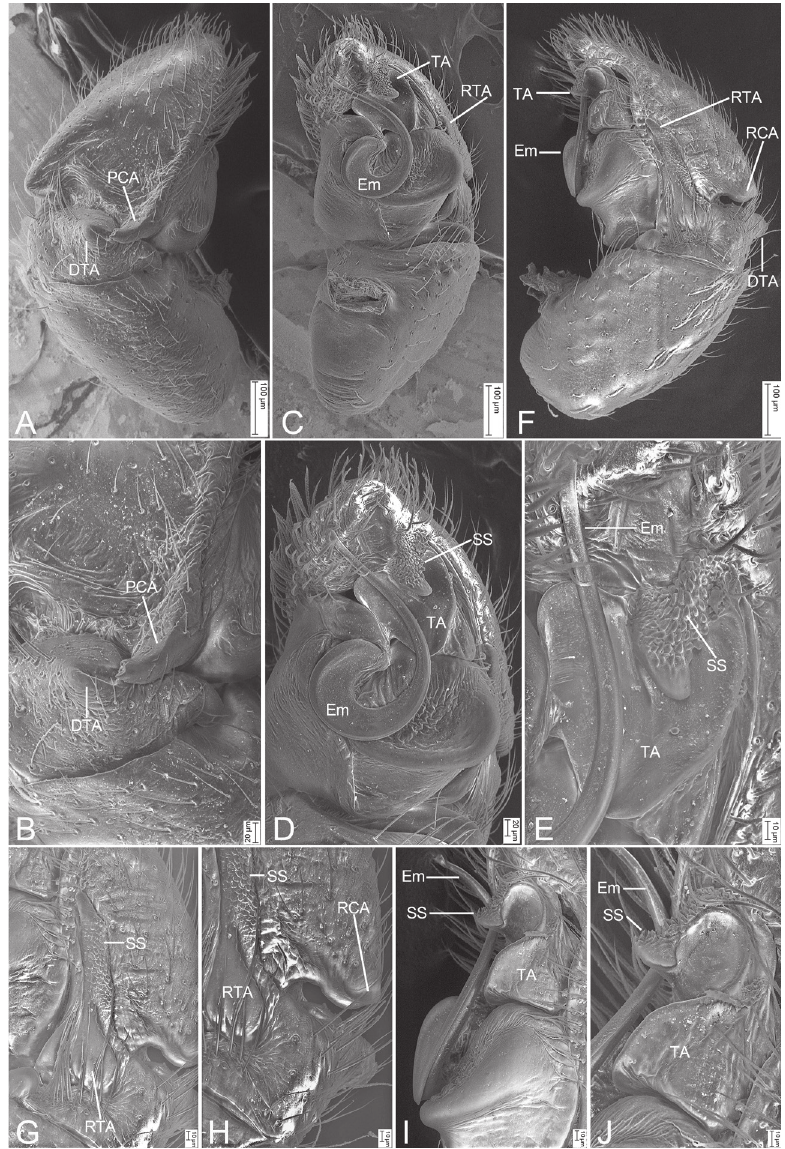
Figure 7. Synagelides serratus sp. nov., SEMs of holotype male A palp, prolateral view, strongly dorsal B same, detail of postero-prolateral cymbial apophysis and dorso-prolateral tibial apophysis, prolateral view, strongly dorsal C same, retrolateral view, slightly retrolateral D same, detail of retrolateral tibial apophysis, ventral view, slightly retrolateral E same, detail of terminal apophysis and embolus, ventral view, slightly retrolateral F same, retrolateral view G same, detail of retrolateral tibial apophysis, retrolat- eral view H same, detail of retrolateral tibial apophysis and postero-retrolateral cymbial apophysis, retro- lateral view I same, detail of terminal apophysis and embolus, retrolateral view J same, detail of terminal apophysis and embolus, retrolateral view. Abbreviations: DTA – dorso-prolateral tibial apophysis, Em – embolus, PCA – postero-prolateral cymbial apophysis, RCA – postero-retrolateral cymbial apophysis, RTA – retrolateral tibial apophysis, SS – scale-like serrations, TA – terminal